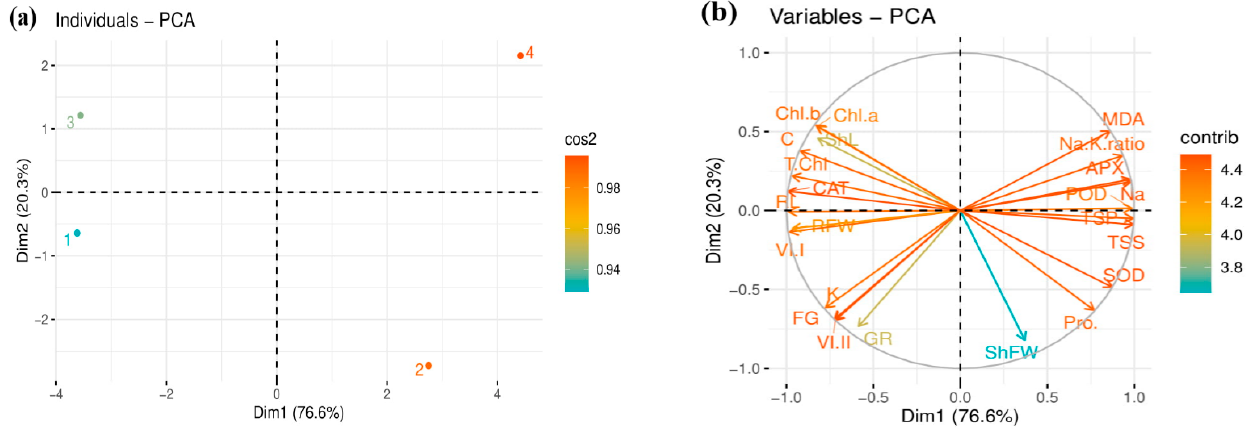
Figure 6. Principal component analysis (PCA) of salt treatment and relationships of variable traits in two rapeseed cultivars: ( a ) PCA score plot of salt treatment on rapeseed seedlings, and ( b ) PCA loading plot of PC1 and PC2 of examined variable traits; circles indicate most correlated variables. Score plot represents separation of treatments as (1) Ck and (2) salinity treatment for Yangyou 9, and (3) CK and (4) salinity treatment for Zhongshuang 11. Tested variables include final germination (FG %); germination rate (GR); vigor index I (VI (I)); vigor index II (VI (II)); shoot length (ShL); root length (RL); shoot fresh weight (ShFW); root fresh weight (RFW); chlorophyll a (Chl a); chlorophyll b (Chl b); total chlorophyll (T. Chl); carotenoid (C) content; total soluble sugar (TSS); total soluble protein (TSP); proline (pro. %); malondialdehyde (MDA) content; sodium ions (Na + ); potassium ions (K + ); superoxidase (SOD) activity; peroxidase (POD) activity; ascorbate peroxidase (APX) activity, and catalase (CAT) activity.